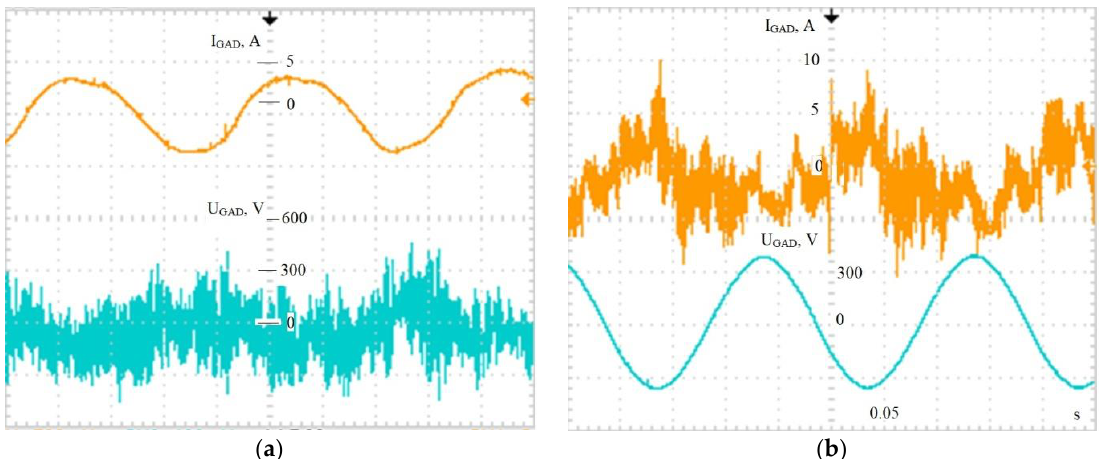
Figure 15. Discharge voltage (blue signal) and current (yellow signal) waveforms while energized form AC/DC/AC inverter: ( a ) In the current source regime current is sine; ( b ) in the voltage source regime voltage is sine; process gas Argon at flow rate 2m 3 /h.